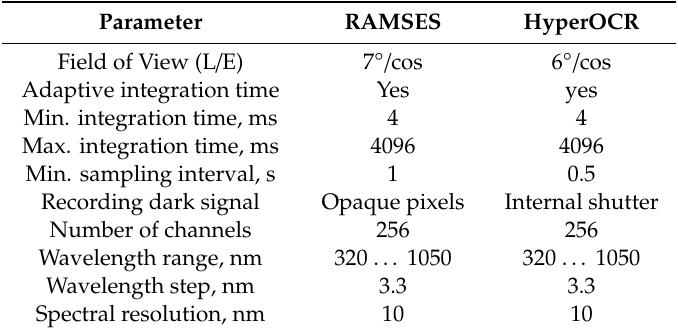
Table 2. Technical parameters of the